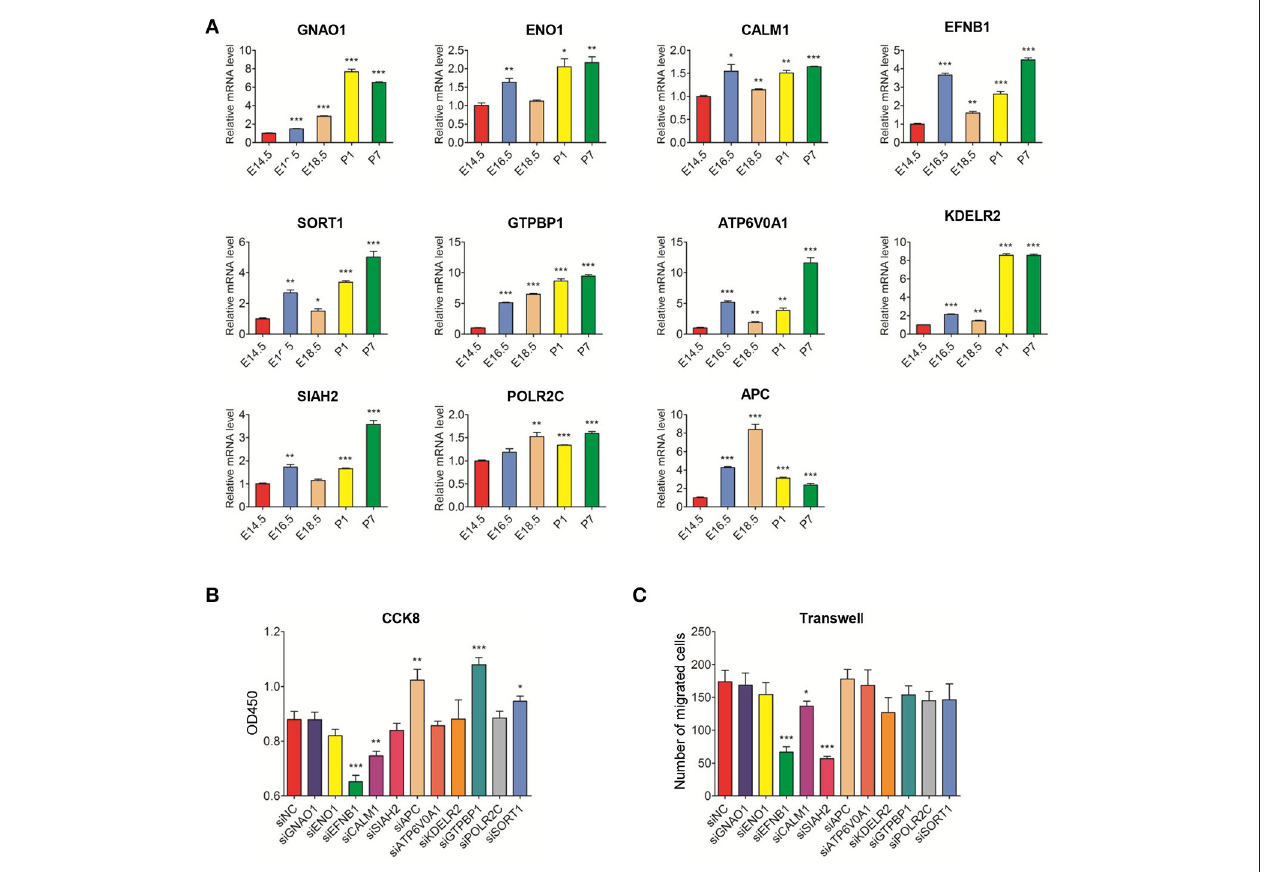
FIGURE 2 | Real-time PCR analysis of DEGs mRNA expression in the development stages of rat tooth germs (E14.5–P7) and the effect of DEG knockdown in rat DPSCs (A) Changes in mRNA levels of DEGs during tooth development. Compared with expression at E14.5 stage, the differential expression levels of DEGs at E16.5, E18.5, P1, and P7 stages were evaluated. Data are shown as the mean ± SD; n = 3. * p < 0.05, *** p < 0.001(Student’s t -test). (B) DPSCs were treated with siNC and siRNA for 96 h and assayed by CCK8. (C) DPSCs were treated with siNC and siRNA for 48h, then the transwell assay was performed. The treated siNC DPSCs was used as a negative control group. The number of migrated cells was displayed as histogram. The data were displayed as the mean value of cells in five fields based on three independent experiments. Results are expressed as the mean ± SD of three independent experiments. * P < 0.05, ** P < 0.01, *** P <